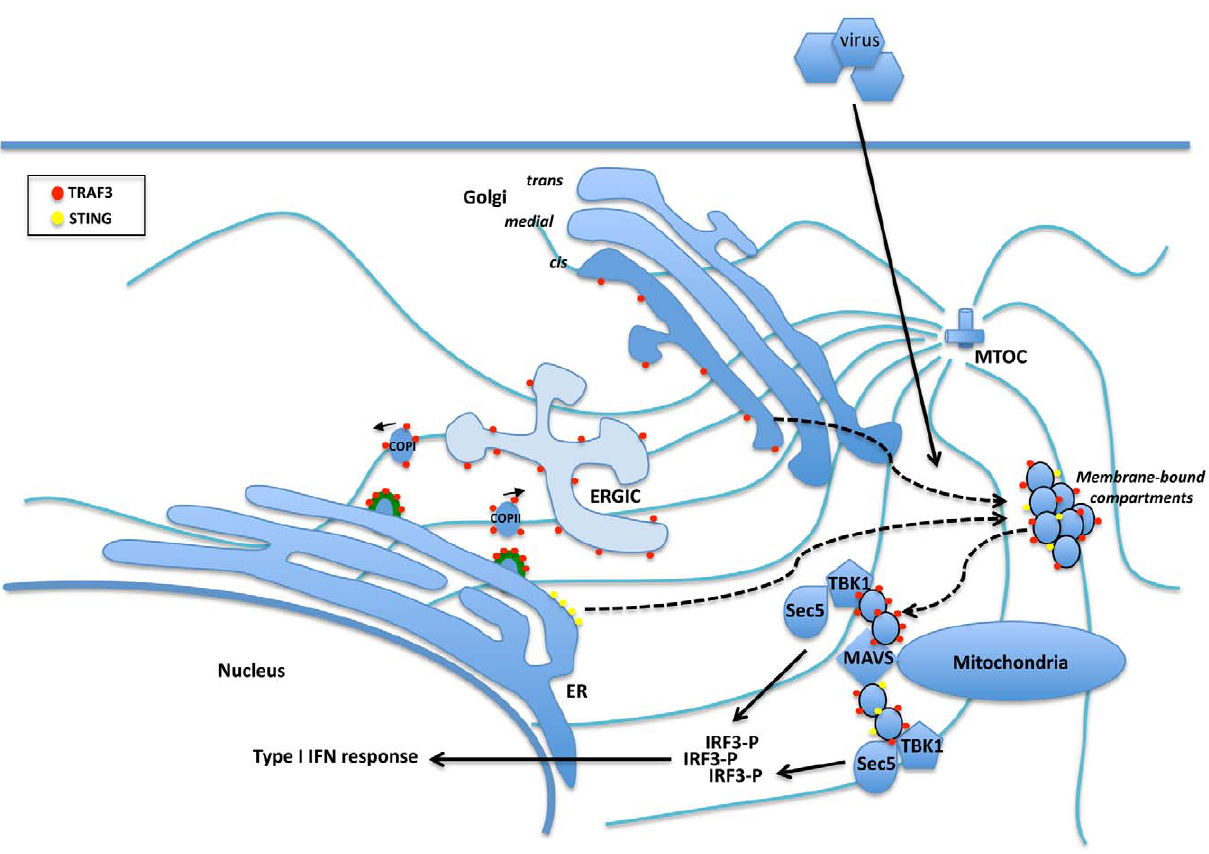
Figure 11. Through its ability to interact and colocalize with components of the ERES (Sec16A, depicted as thick green lines), ERGIC (ERGIC53 and p115) and the cis-Golgi apparatus (p115 and GM130), a subpopulation of TRAF3 (red circles) resides in the ER-to- Golgi vesicular compartment in non-infected cells. Upon dsRNA and dsDNA sensing, the cis-Golgi disorganizes into punctate structures, giving rise to membrane-bound compartments composed of at least GM130 and TRAF3 (dashed line). We propose that these membrane-bound compartments allow the proper positioning of TRAF3 with MAVS at Mitochondrial-Associated endoplasmic reticulum Membranes (MAM) [86]. There, being in close proximity with a component of the exocyst (sec5) and the translocon (Sec61 b ), TRAF3 allows the activation of TBK1 and IRF3 leading to activation of the type I IFN response. A similar scenario was recently proposed for STING (yellow circles) where in response to DNA virus infection, it traffics from the ER to the cis-Golgi apparatus and finally to a distinct perinuclear region for the activation of TBK1 [61,62]. MTOC: